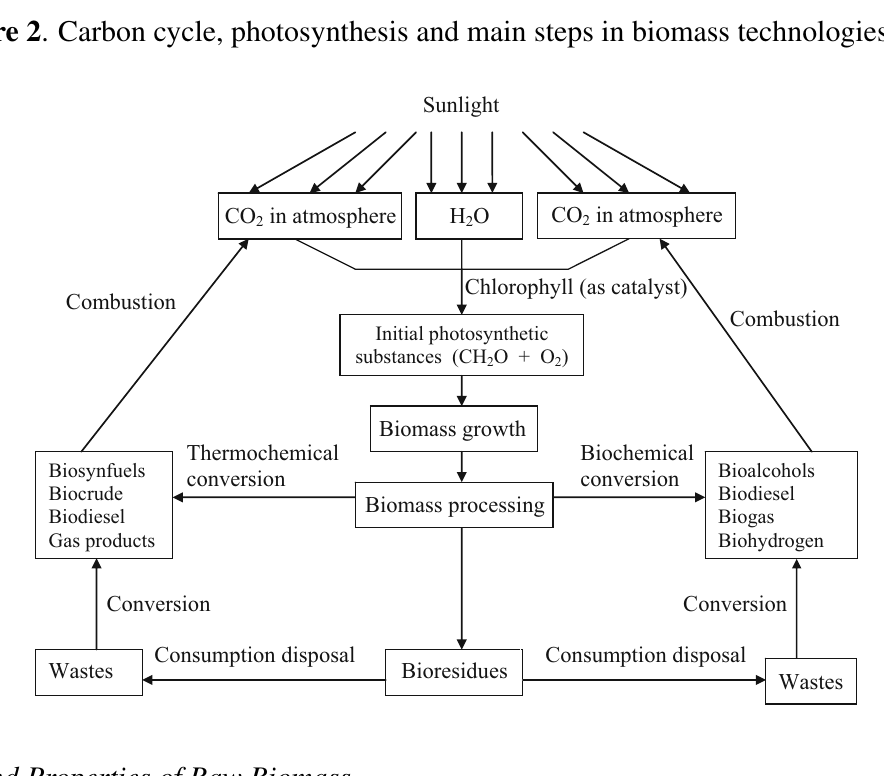
Figure 2 . Carbon cycle, photosynthesis and main steps in biomass technologies